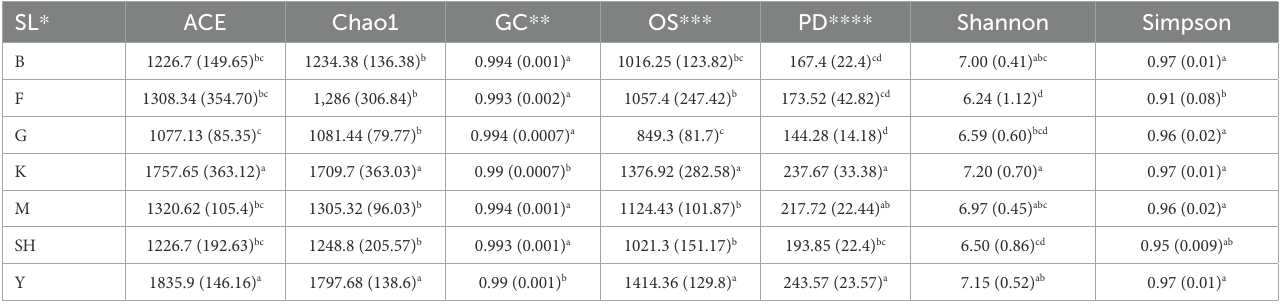
TABLE 1 Alpha diversity indices of rarefied data.